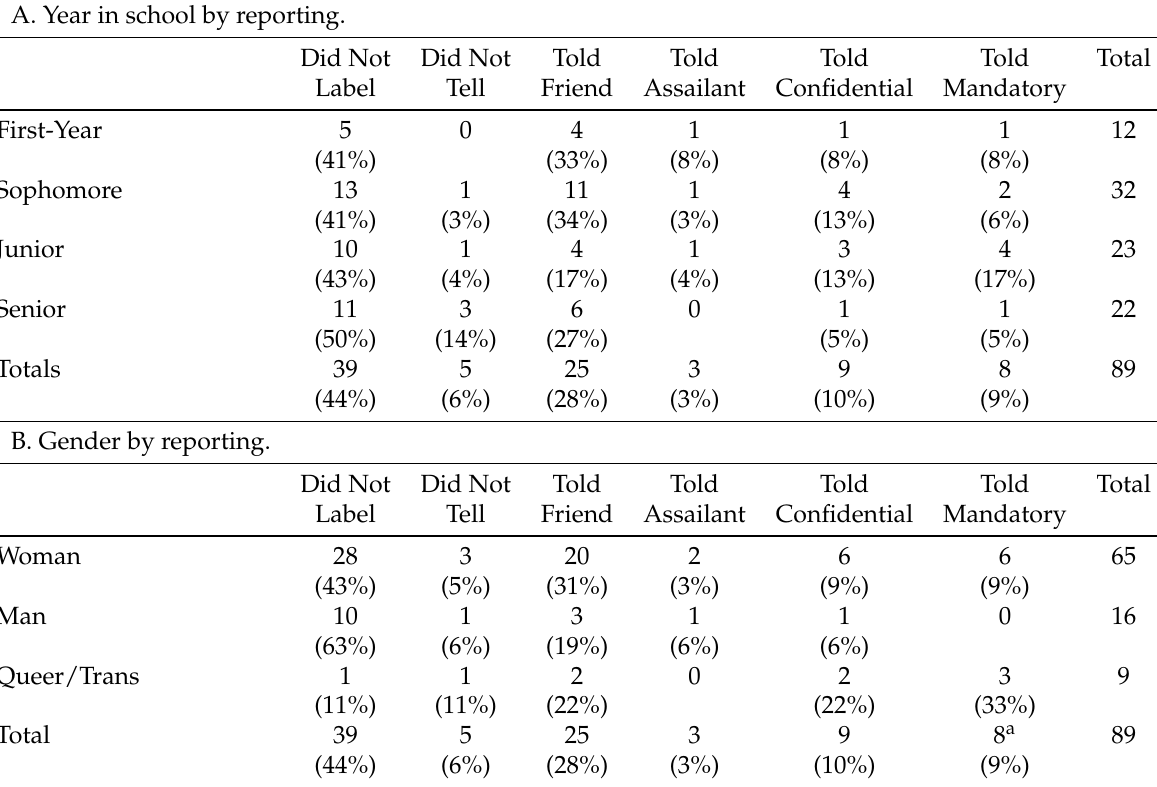
Table 2: Labeling, telling, and reporting sexual assault by year in school and gender. A. Year in school by